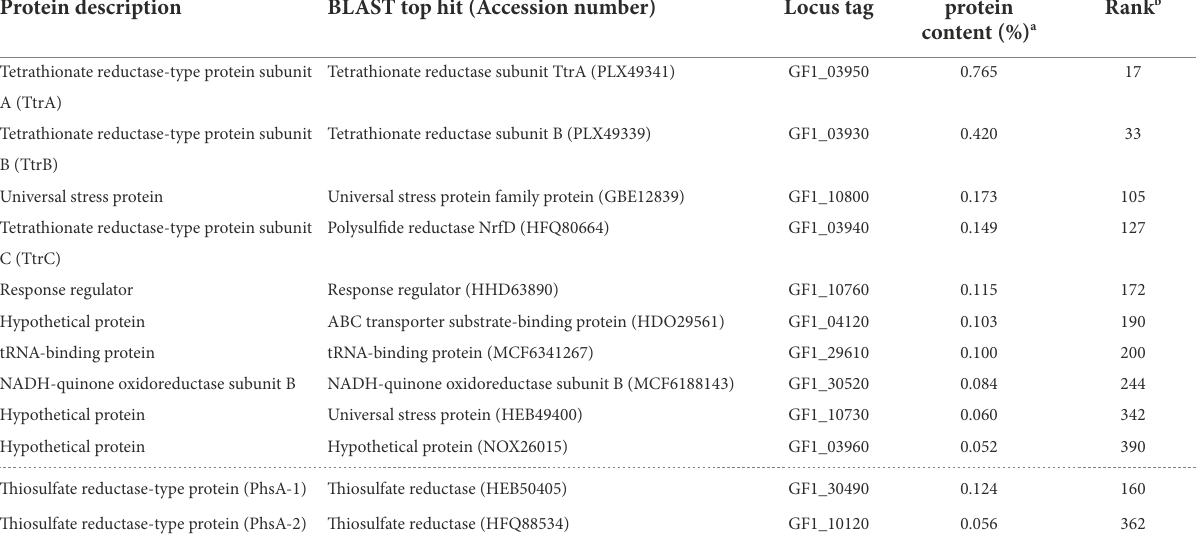
Protein descriptions are based on automatic annotation with DFAST and manual curation using the BLAST algorithm. Thiosulfate reductase-type proteins are listed for comparison. a Based on the average NSAF values of the biological triplicates. b Rank of relative protein content in